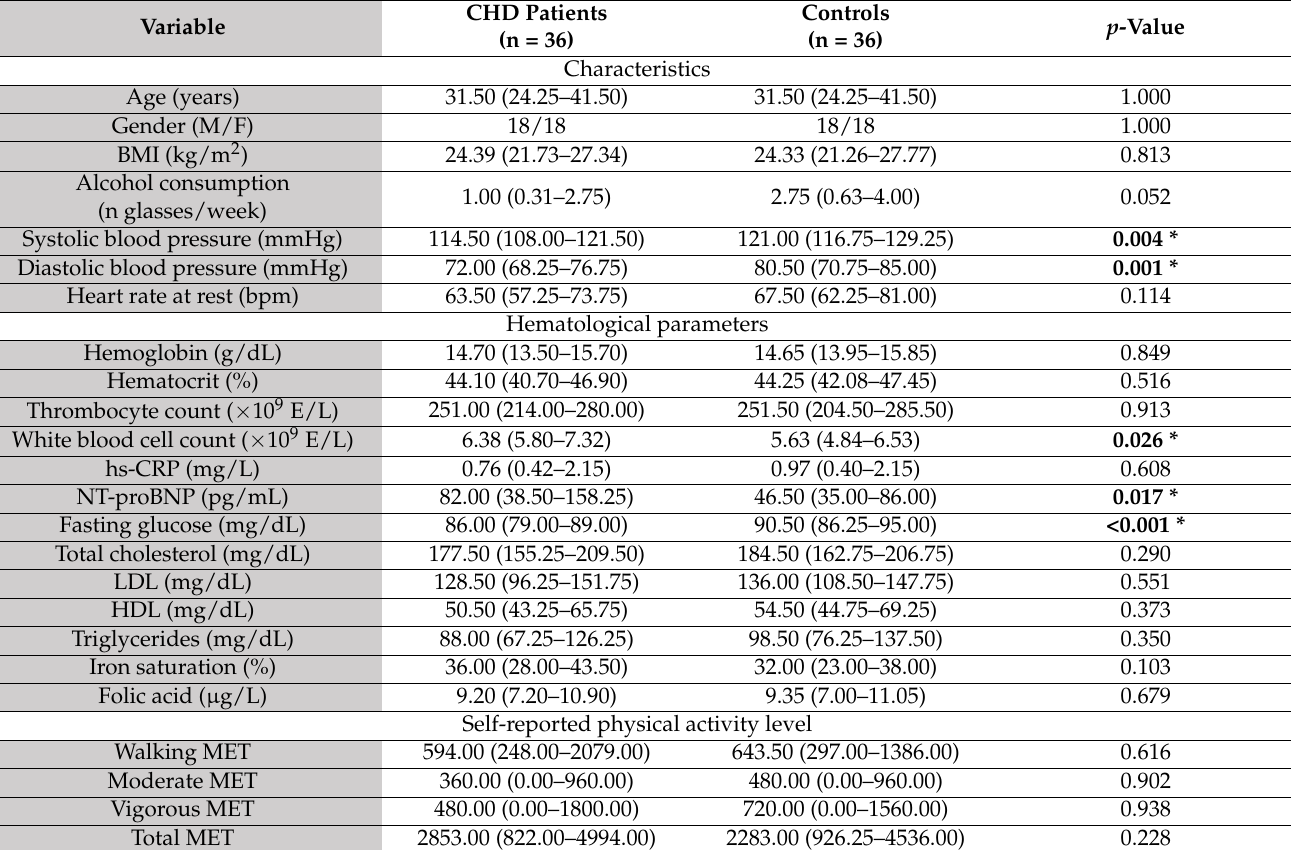
Table 1. Characteristics, hematological parameters and self-reported physical activity levels of the CHD patients and healthy